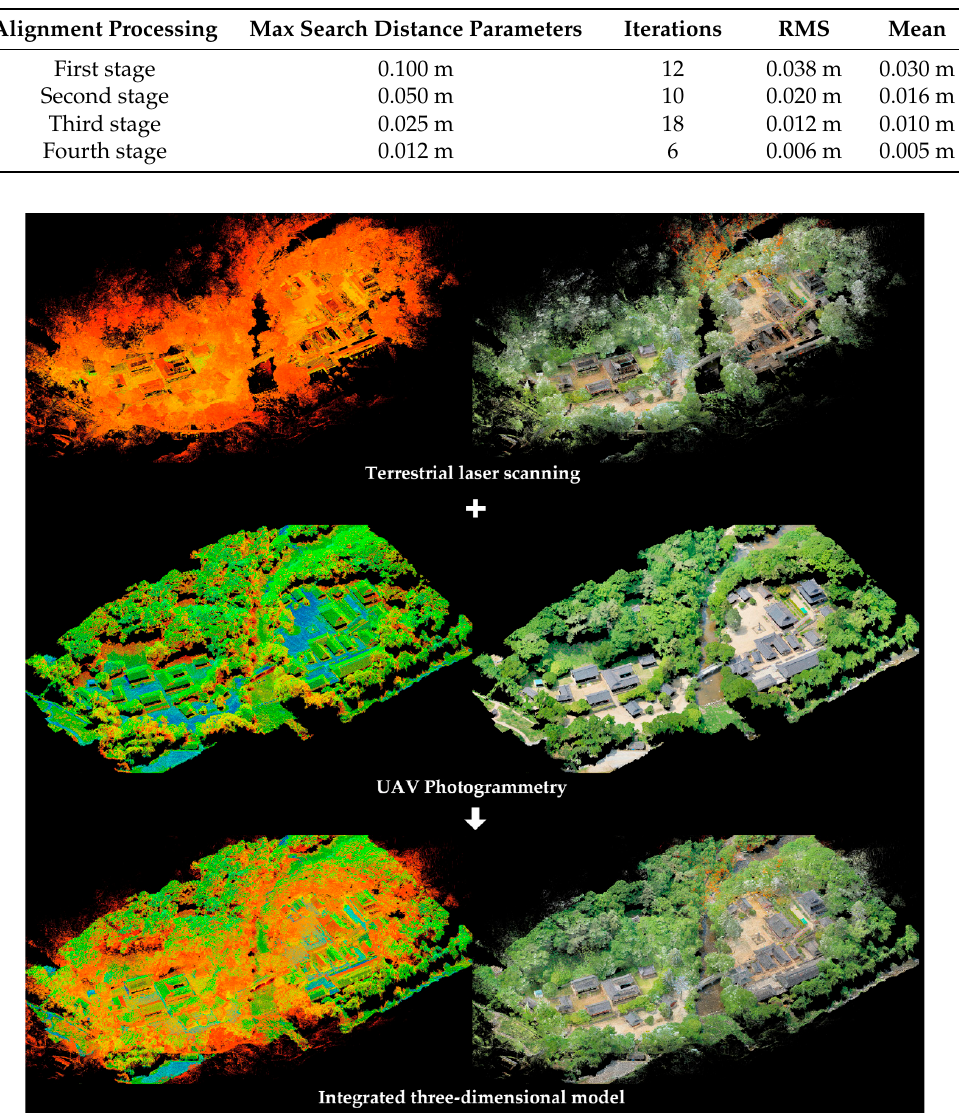
Figure 9. Process and result of integrated 3D modeling.